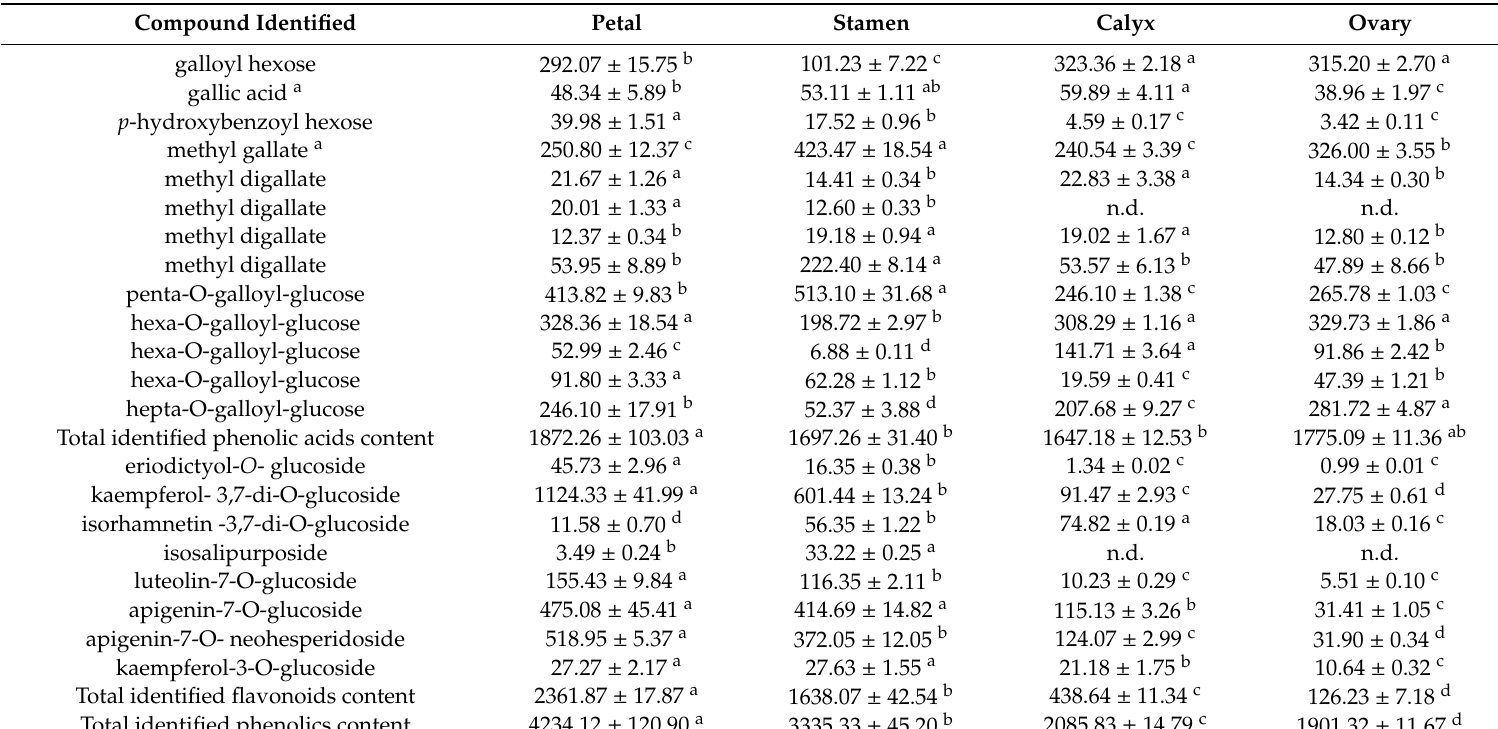
Table 2. Content of individual phenolic compounds (mg / 100 g DW 1 ) in the di ff erent organs of the tree peony flower 2